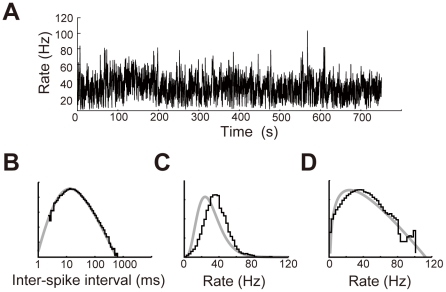
Estimation of the firing rate in cortical neurons.(A) The value of κ ( = 3.49) was estimated by the method used in Miura et al. (2007) [35] and the instantaneous firing rate was estimated for a cortical neuron according to the method proposed in Koyama and Shinomoto (2005) [34]. (B) Double-logarithmic histogram of ISIs constructed for the spike train shown in (A) exhibited a power-law decaying tail (black). The histogram was fitted with a beta-2 distribution (gray). (C) Distribution of the estimated instantaneous firing rate (black) was fitted with a gamma distribution (gray). (D) The semi-logarithmic plot of the same rate distribution exhibits an exponentially decaying tail (black) characteristic to the gamma distribution (gray).